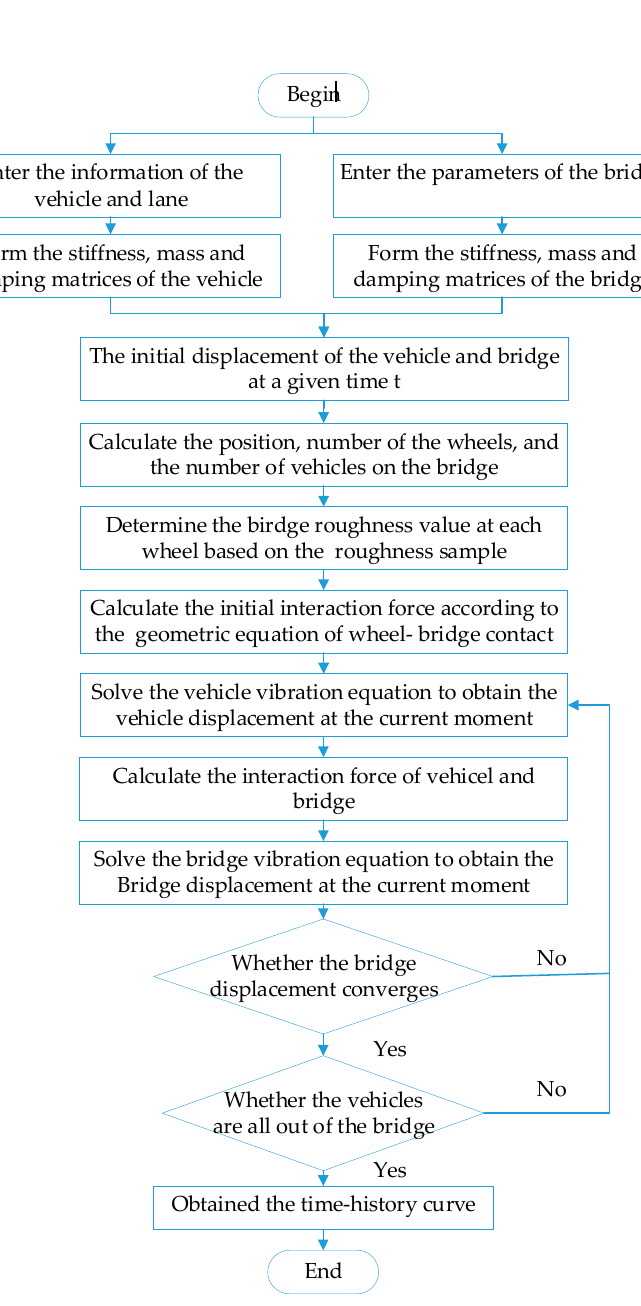
Figure 7. Solution flow of the vehicle-bridge coupled vibration.